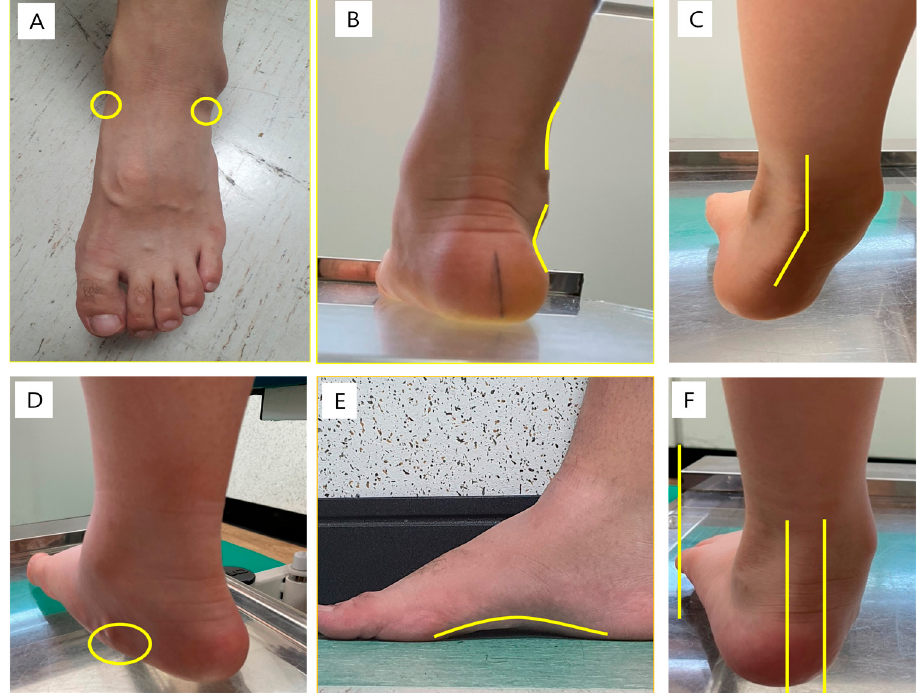
Figure 2. Measurements of the foot posture index (FPI). ( A ) Talar head palpation; ( B ) Supra- and infra-lateral malleolar curvature; ( C ) Calcaneal inversion/eversion; ( D ) Prominence of the talonavicular joint; ( E ) Congruence of the internal longitudinal arch; and ( F ) Abduction/Adduction of the forefoot with respect to the rear foot.